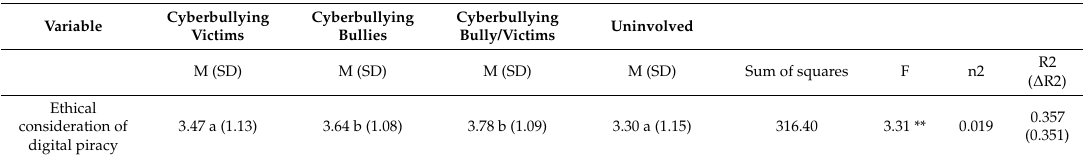
Table 6. Summary of the ANCOVA